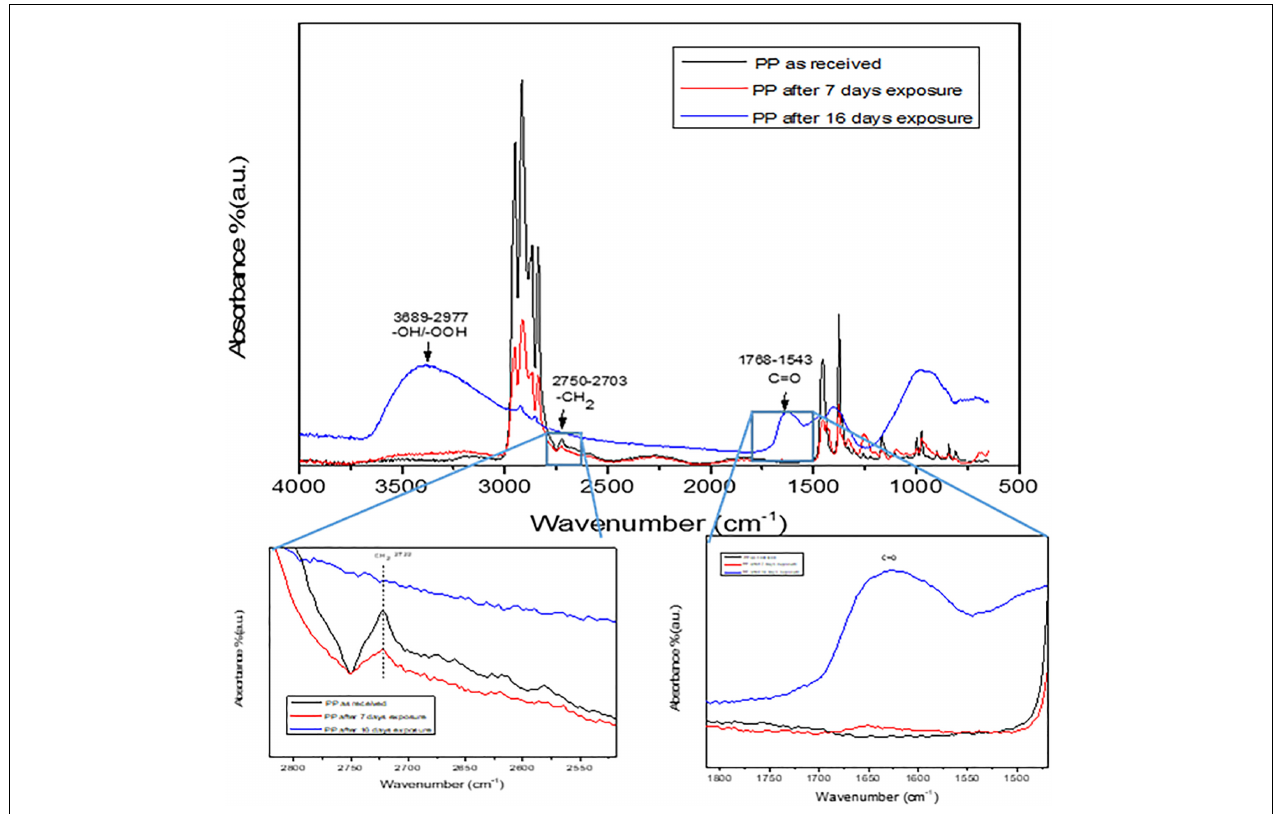
FIGURE 3 | FTIR spectrum of PP microplastics degradation using Photo-Fenton process. The carbonyl and carboxyl groups are highlighted in the spectra.